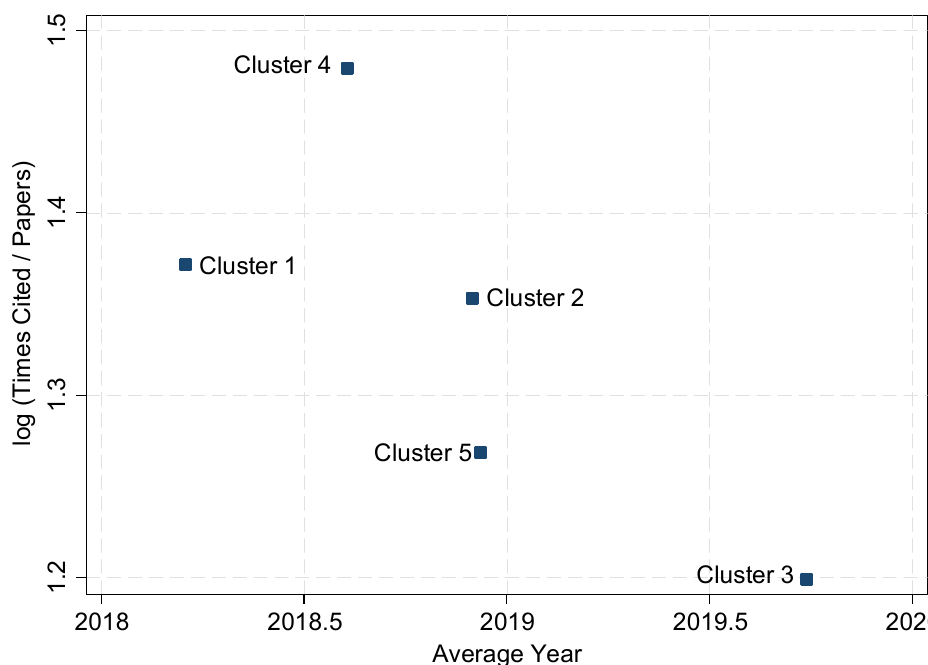
Figure 8. Longitudinal analysis of the most significant keywords.